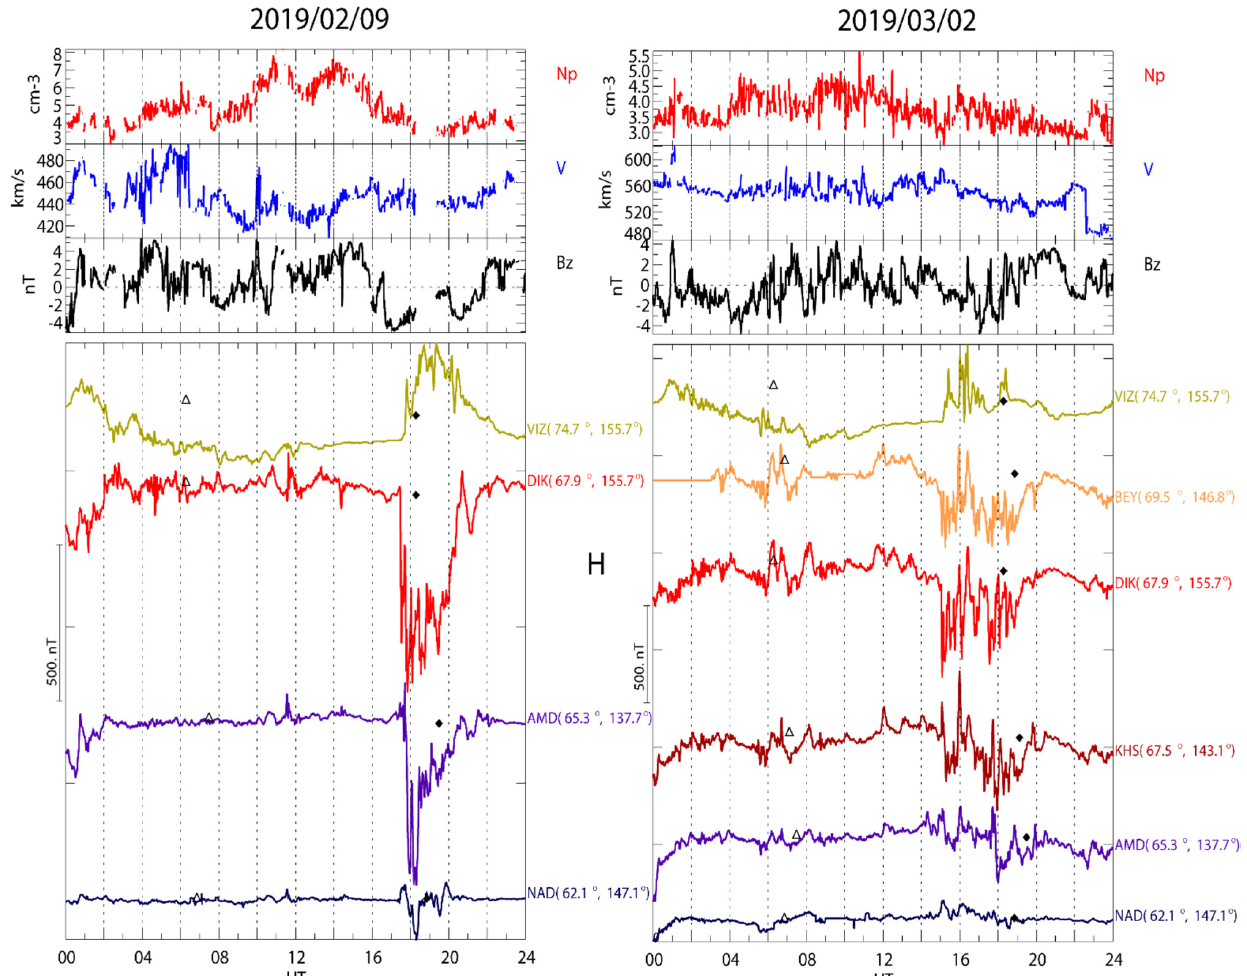
Figure 2. An example of irregular quasiperiodic Pi3 pulsations against the background of the expansion phase of a substorm on 9 February 2019 ( left ) and 2 March 2019 ( right ). The top panel in both plots shows variations in the solar wind plasma density N p, solar wind velocity V , and vertical component of the interplanetary magnetic field B z. Stack-plot magnetograms of the H-component from stations around Yamal Peninsula are shown in the bottom panel. Geomagnetic coordinates of the stations are indicated on the lower panels next to the station code. On the magnetograms, empty triangles show local noon at each station, and black diamonds show local midnight.